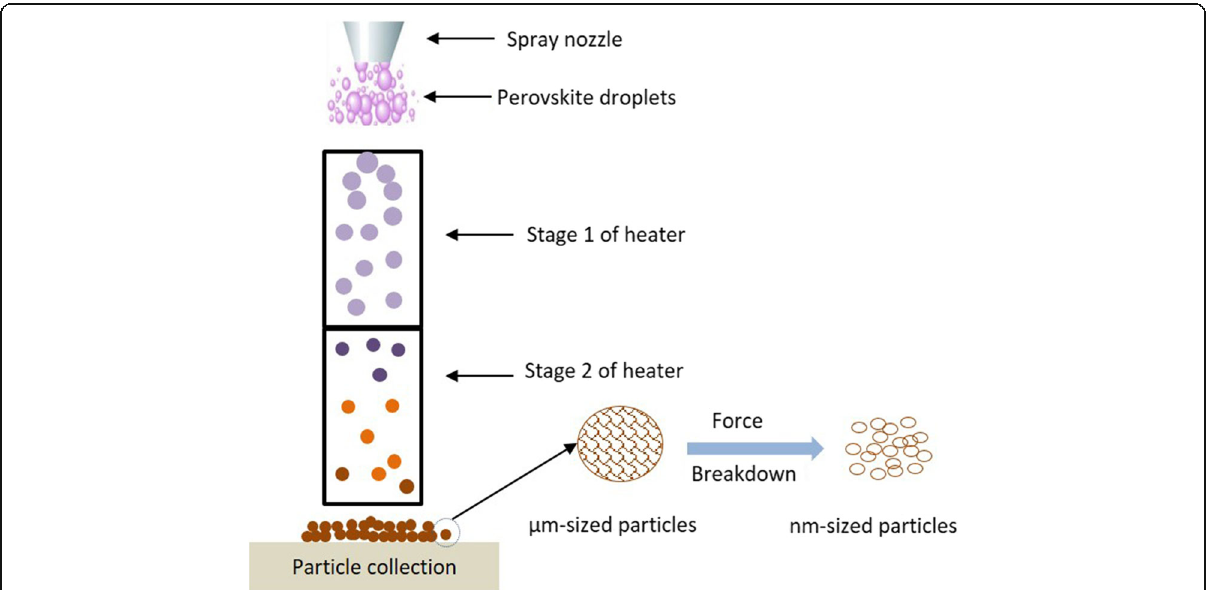
Fig. 5 Schematic of the proposed method for the preparation of micrometer-sized and nanometer-sized perovskite particles in a suggested two-stage heater. The first stage is for rapid solvent evaporation (~275 °C), whereas the second stage (~175 °C) is for complete drying and in situ annealing